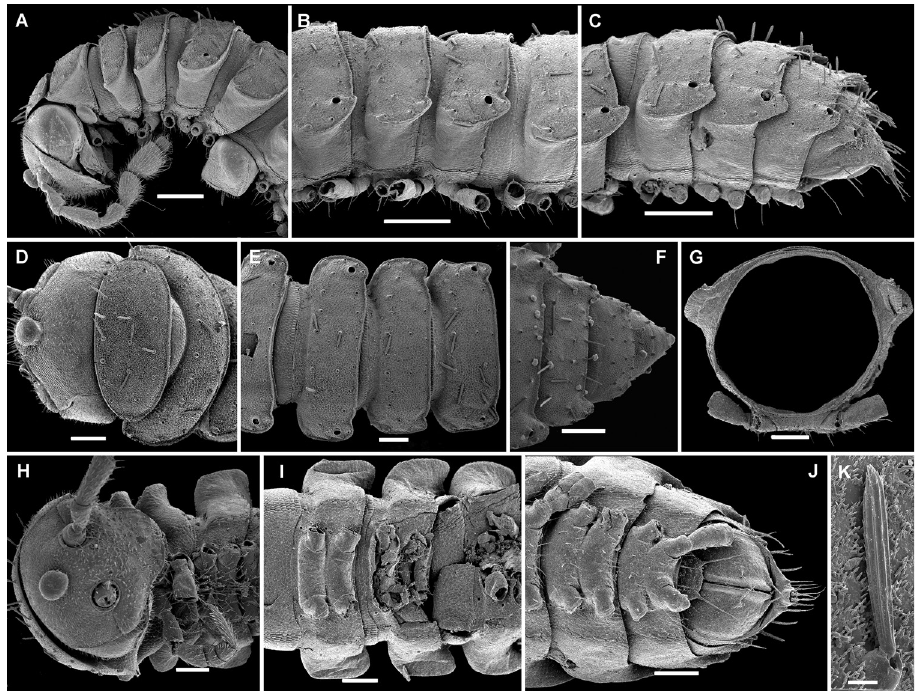
Figure 9. Hemisphaeroparia ongot sp. n., SEM micrographs of ♂ paratype A, D, H anterior part of body, lateral, dorsal and ventral views, respectively B, E, I midbody segments, lateral, dorsal and ventral views, respectively C, F, J posterior part of body, lateral, dorsal and ventral views, respectively G midbody seg- ment, caudal view K tergal seta, lateral view. Scale bars: 0.2 mm ( A–C ), 0.1 mm ( D–J) , 0.01 mm ( K